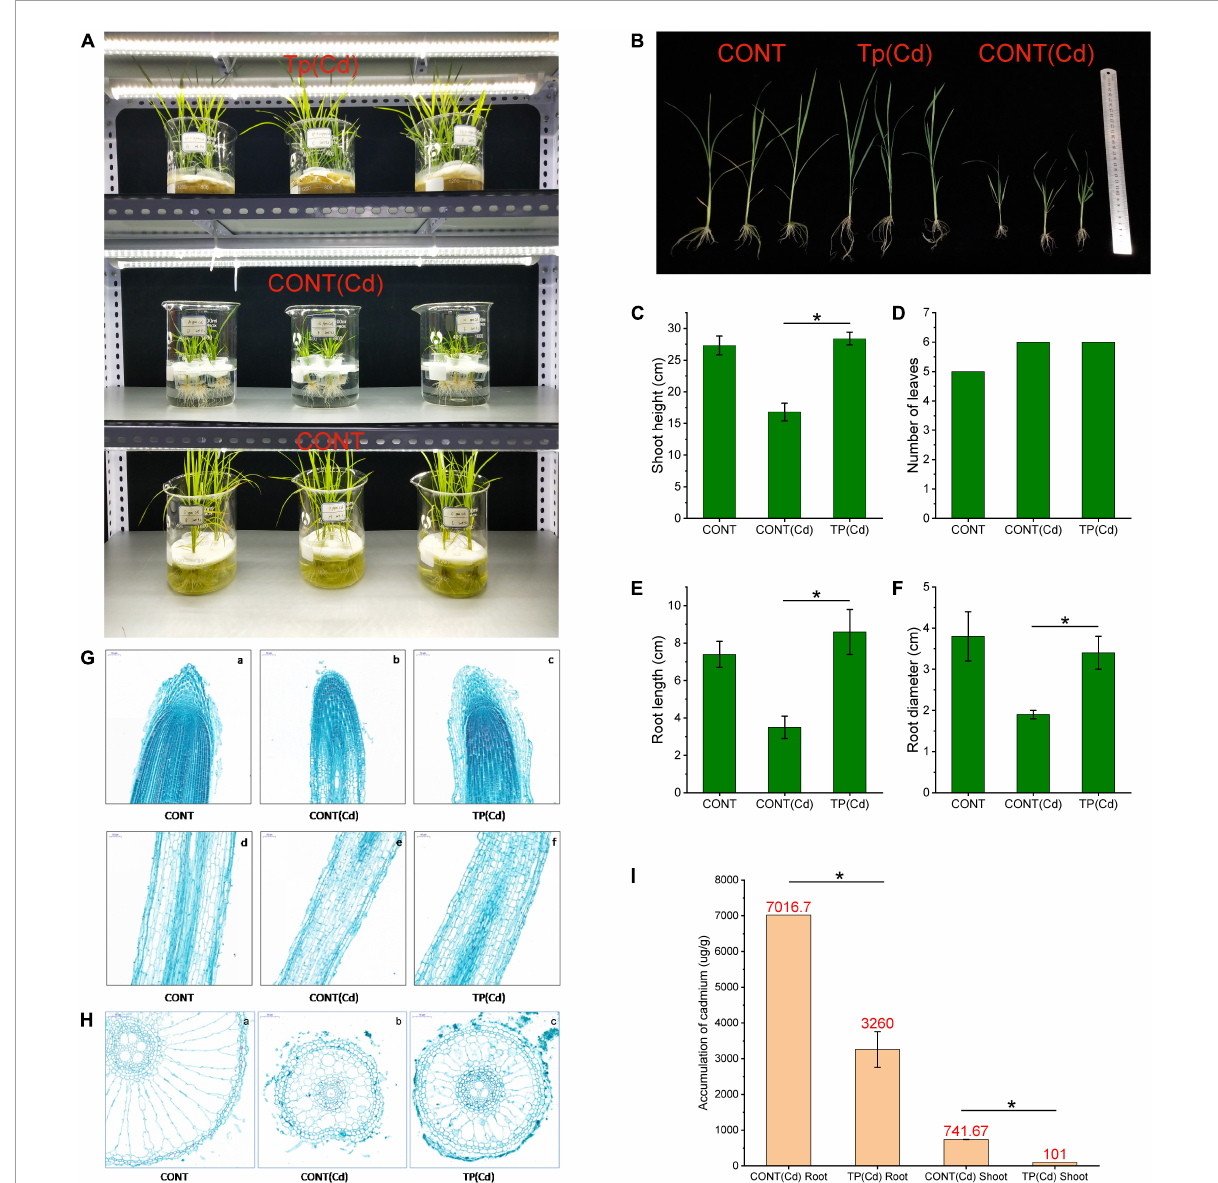
FIGURE2 Effect of T. pubescens colonization on rice seedlings under Cd stress. (A) Fungus-rice coculture model constructed in the laboratory. (B) The effect of T. pubescens colonization on the growth of rice seedlings under Cd stress. (C) Shoot height of rice seedlings. (D) Leave number of rice seedlings. (E) Root length of rice seedlings. (F) Root diameter of rice seedlings. (G,H) Paraffin section of rice root tissues under Cd stress, (a–c) longitudinal section of root tip and (d–f) cross section of root. (I) Accumulation of Cd in root and shoot of rice after 15 days culture. * Indicates significant differences between groups ( p < 0.05). Cd, cadmium; CONT, no Cd treatment group; CONT(Cd), Cd treatment and without T. pubescens colonization group; Tp (Cd), Cd treatment and with T. pubescens colonization group.